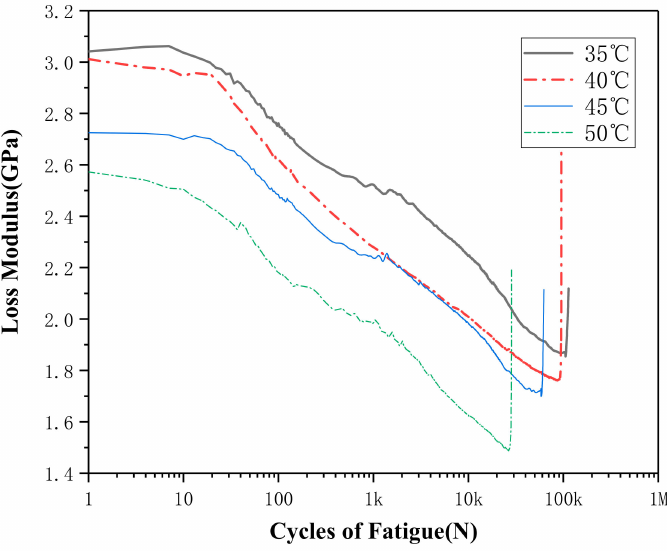
Figure 9. Loss modulus curve of di ff erent strain amplitudes at 40 ◦ C.